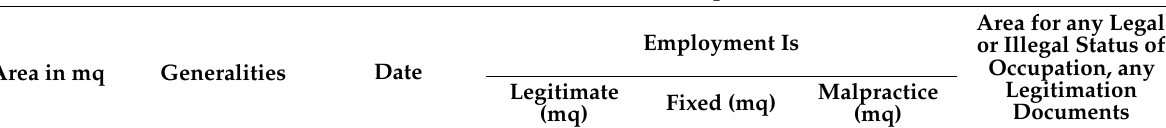
Table A1. Cont . Location Acertained